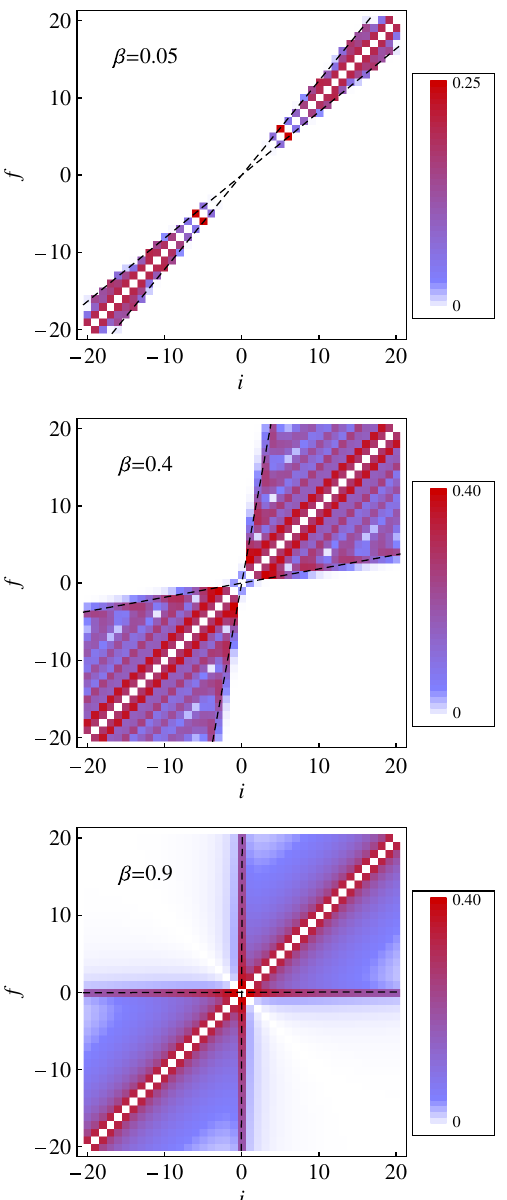
j for FIG. 8. Color-scale plots of the transition amplitudes j T ð 1 Þ fi (cid:9) ¼ 0 : 4 and 0.9 as a function of the initial and final energies E ð v Þ i and E ð v Þ (instead of the quantum numbers i and f as in Fig. 7). ffiffiffi f p n These plots emphasize the dependence of the energies E ð v Þ n , as well as the squeezing of the energy spectrum for (cid:9) ! 1 . For (cid:9) ¼ 0 : 9 , the squeezing implies that there are (cid:4) 3 (cid:8) 12 times as many states in a fixed energy range compared to the static case.